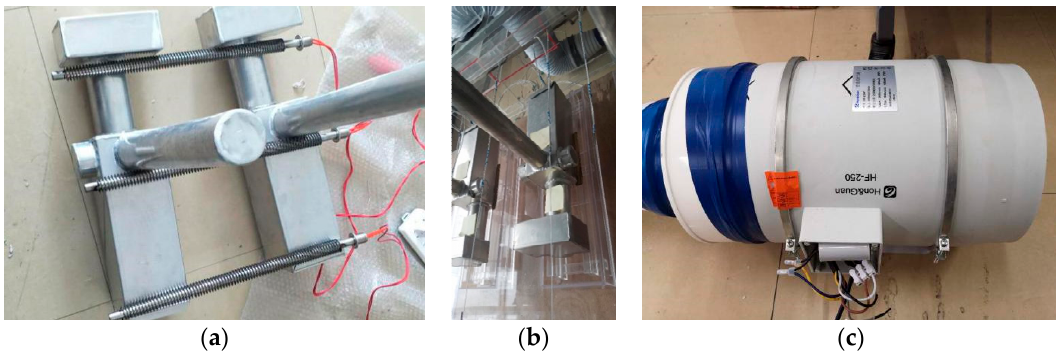
Figure 11. Diagram and image of the experimental platform. Appl. Sci. 2019 , 9 , x FOR PEER REVIEW